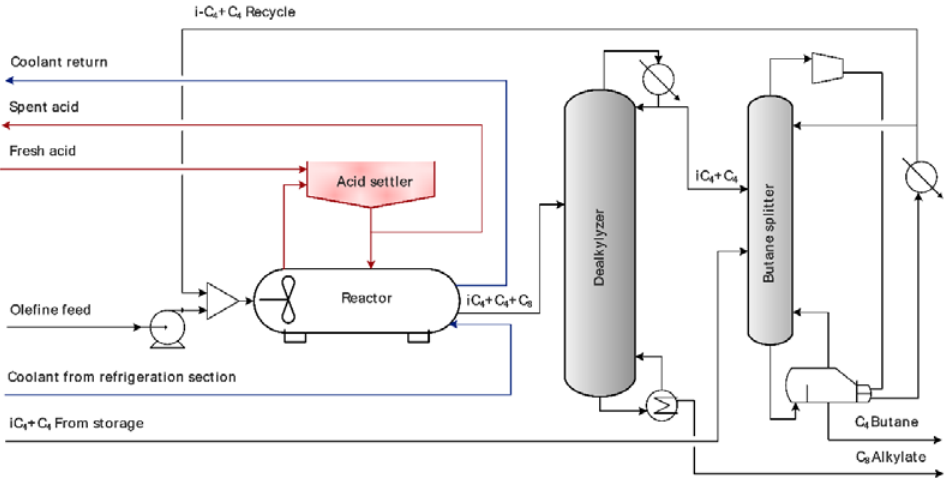
Figure 4. Alkylation process revamp option via heat pump-assisted C4 stream splitting. Adapted from [5].